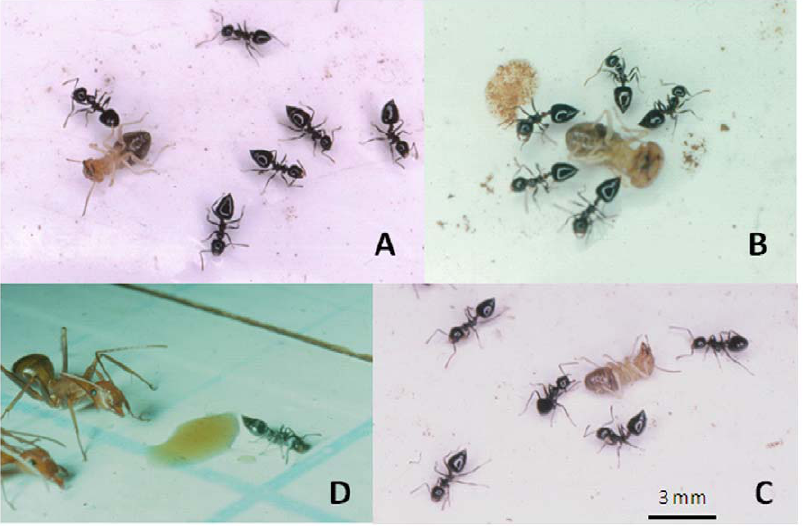
Figure 1. Crematogasterstriatula ants capturing a termite worker. Workers firstly surrounded the termite at a distance of 5–10 mm, their abdominal tip pointed toward the prey. A. After ca. 10 minutes the termite fell down and rolled onto its back, its legs batting the air. One ant approached it very slowly. B. When there were fewer movements of its legs, all of the ants approached the termite. C. Later the ants prepared to seize the termite by an appendage to retrieve it to their nest. D. Interspecific competition. A Crematogaster striatula worker that had discovered several Camponotus brutus imbibing honey on its territory caused them to retreat by very slowly approaching in a backward movement, with its abdominal tip pointed toward the aliens. No contact between the antagonists was noted.